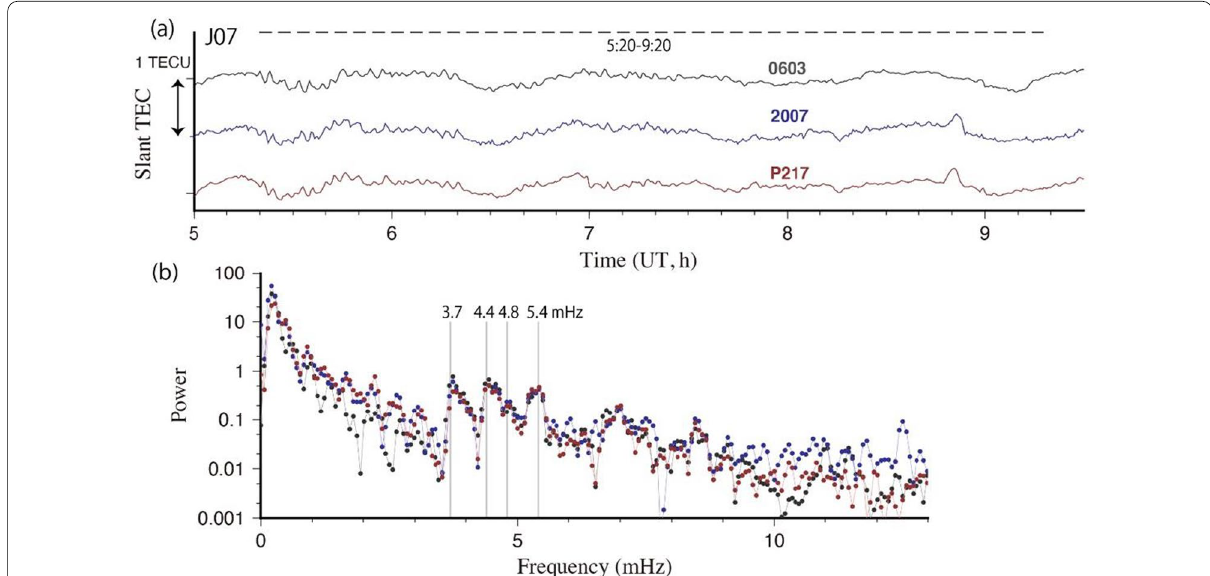
Fig. 5 a High-pass filtered slant TEC time series at three stations observed using J07, the QZSS geostationary satellite, at three GNSS stations 0603, 2007, and P217 (Fig. 1b). Frequency components of the 4-h data 5:20–9:20 UT (shown with a dashed line) obtained using the Blackman–Tukey method are shown in ( b ). We see three strong peaks (3.7, 4.4, and 5.4 mHz) and one weaker peak (4.8 mHz) for the TEC data at all the three stations (colors correspond to those in ( a